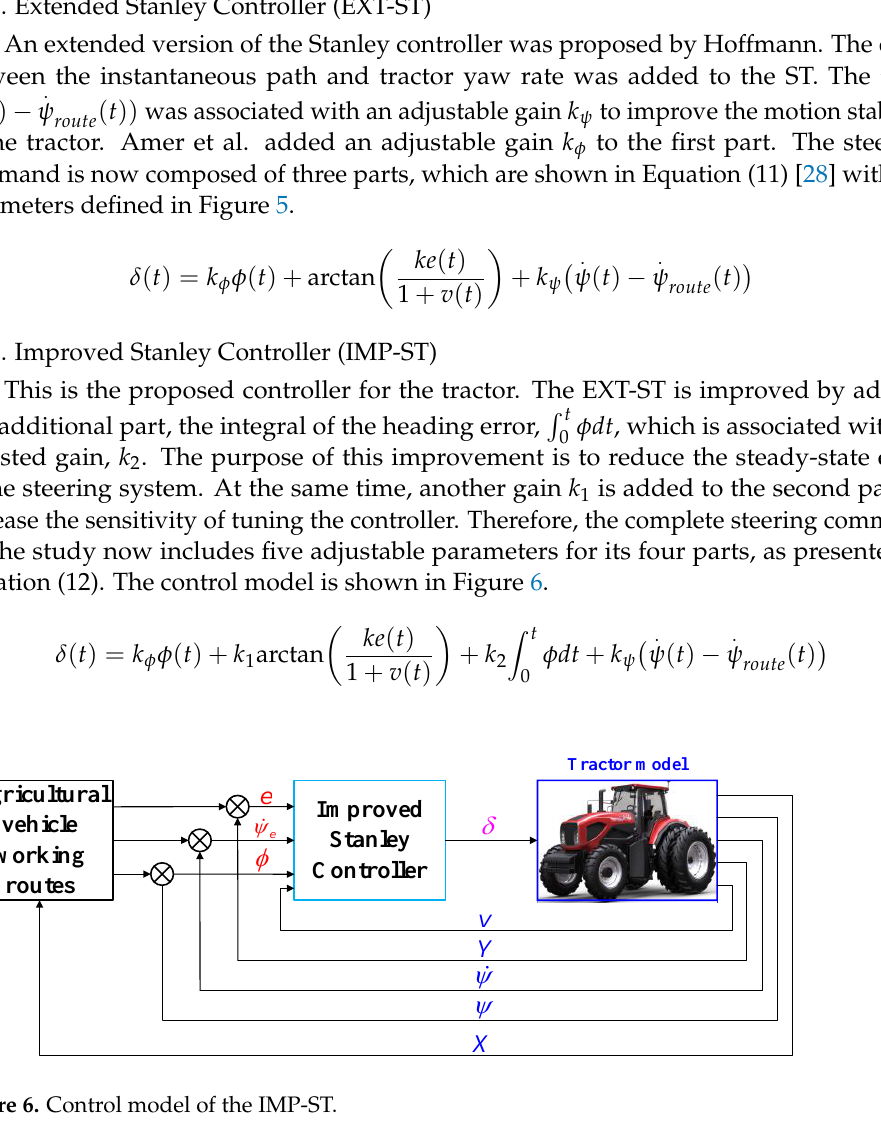
Figure 5. Parameters of the Stanley controller.